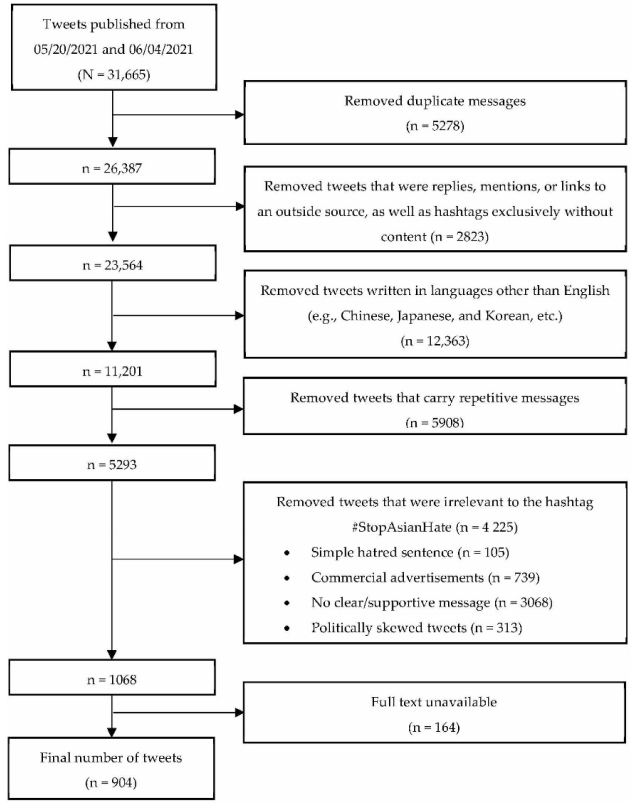
Figure 1. Data mining process using